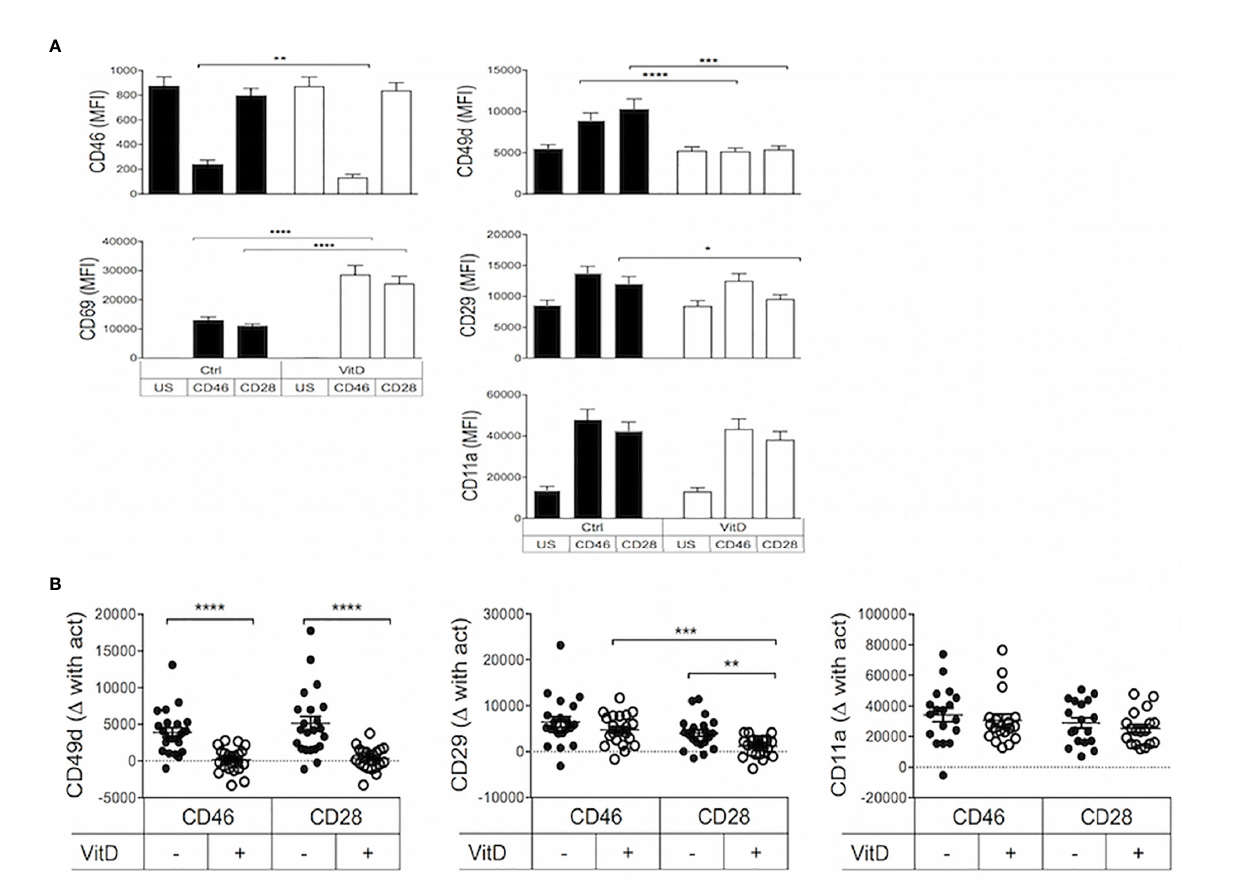
FIGURE 1 | 1,25(OH)2D3 differentially modulates integrin surface expression on activated T cells depending on their activation pathway. (A) Human CD4+ T cells were left unstimulated (US) or were activated with anti-CD3 and anti-CD28 or anti-CD46 as indicated, in the presence or absence of 1,25(OH)2D3 (VitD). After 4 days, expression of CD46, CD69, CD49d, CD29, and CD11a was assessed by fl ow cytometry (mean ± SEM, n= 24, one way ANOVA with Holm-Sidak ’ s multiple comparisons post hoc test). (B) The change in expression of CD49d, CD29, and CD11a upon activation compared to expression in unstimulated T cells was calculated (mean ± SEM, n= 22, Friedman test with Dunn ’ s multiple comparisons test). *: p<0.05 to 0.01, **: 0.001 to 0.01, ***: 0.0001 to 0.001, and ****: <